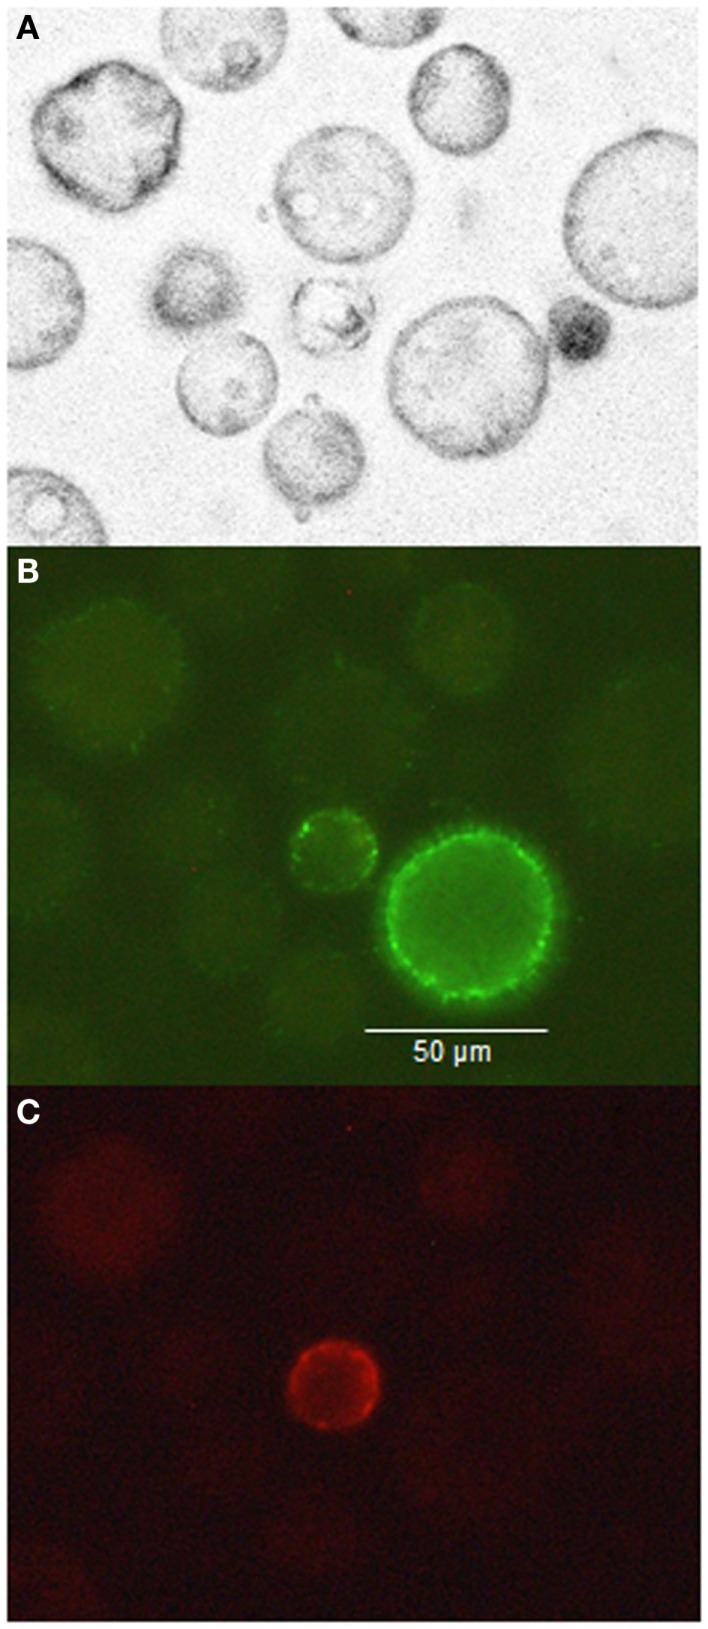
Milk cells marked with antibodies (anti-CD14 with FITC and anti CD45 with PE) visualized natively (A), using a 530-nm band pass filter for FITC (B), and using a 585-nm band pass filter for PE (C).